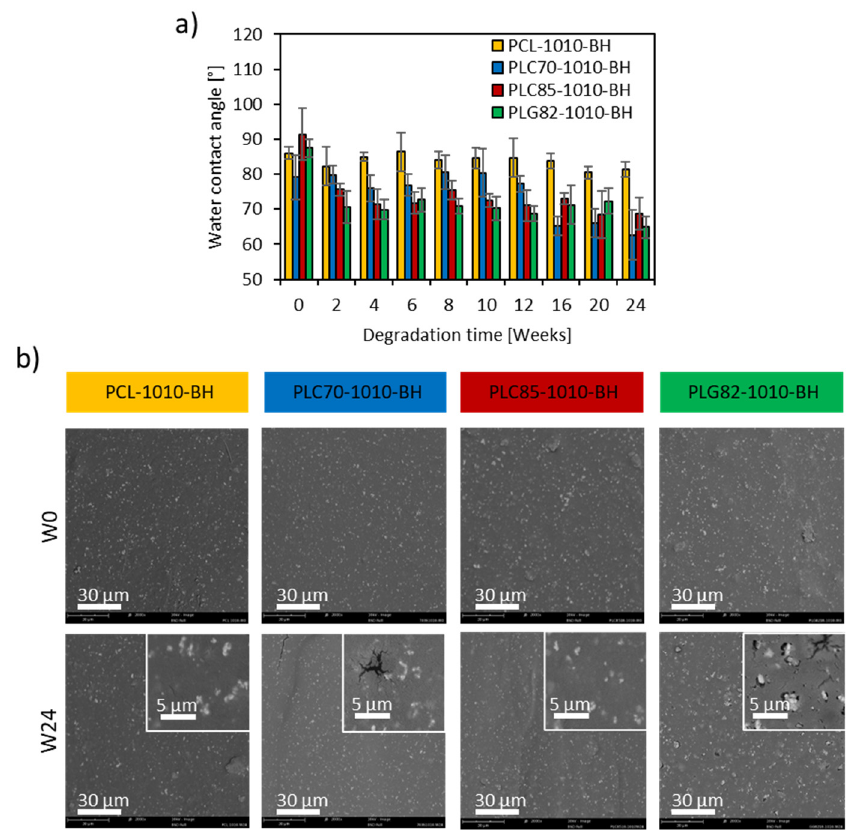
Figure 6. ( a ) WCA within the degradation experiment; ( b ) morphology of the surface of composite rods at W0 and